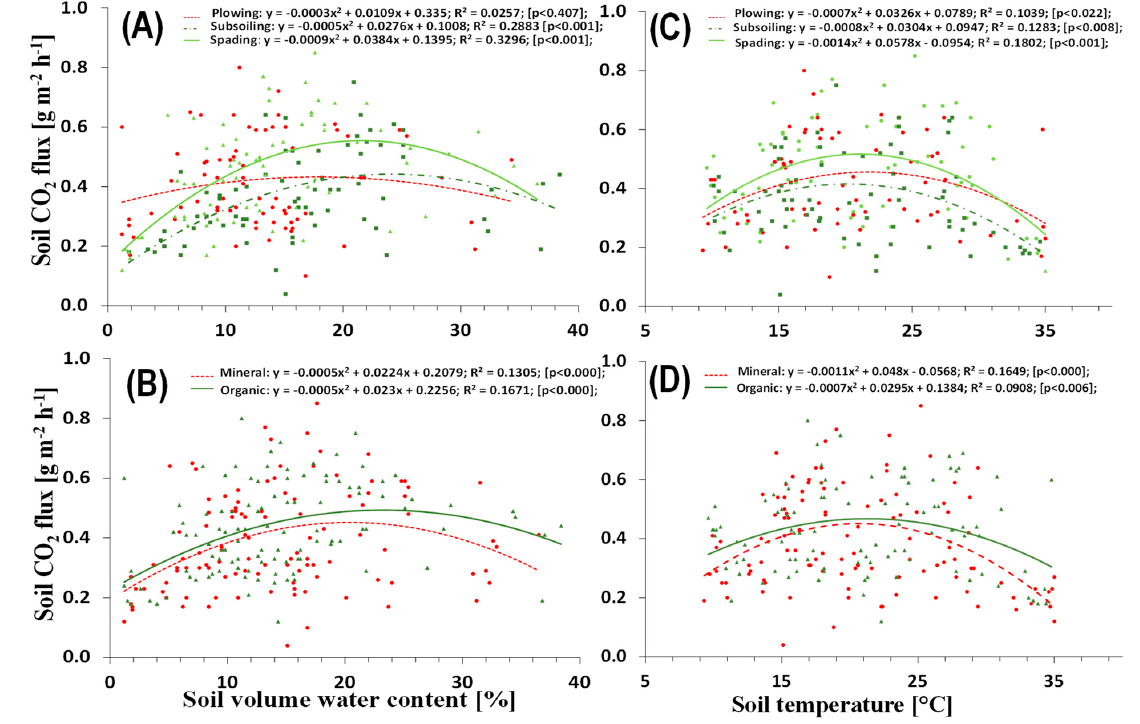
Figure 5. Soil CO 2 flux plotted against soil volumetric water content and soil temperature under soil tillage practices: plowing (P), subsoiling (R), and spading (S), and under inorganic (M), organic (O) fertilization sources for both the 2021 and 2022 durum wheat growing seasons. Soil CO 2 flux plotted against soil volumetric water content under different tillage ( A ) and different fertilizers ( B ). Soil CO 2 flux plotted against soil temperature under different tillage ( C ) and different fertilizers ( D ).